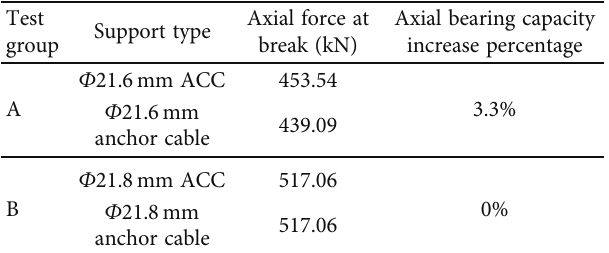
Figure 14: Anchor cable structure.